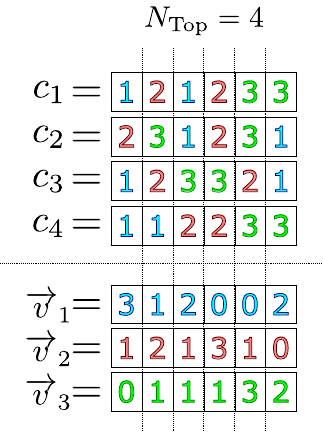
Figure 1. Calculating the frequency vectors ( (cid:126) v i ) of the three jobs in each coordinate of the four best chromosomes in the